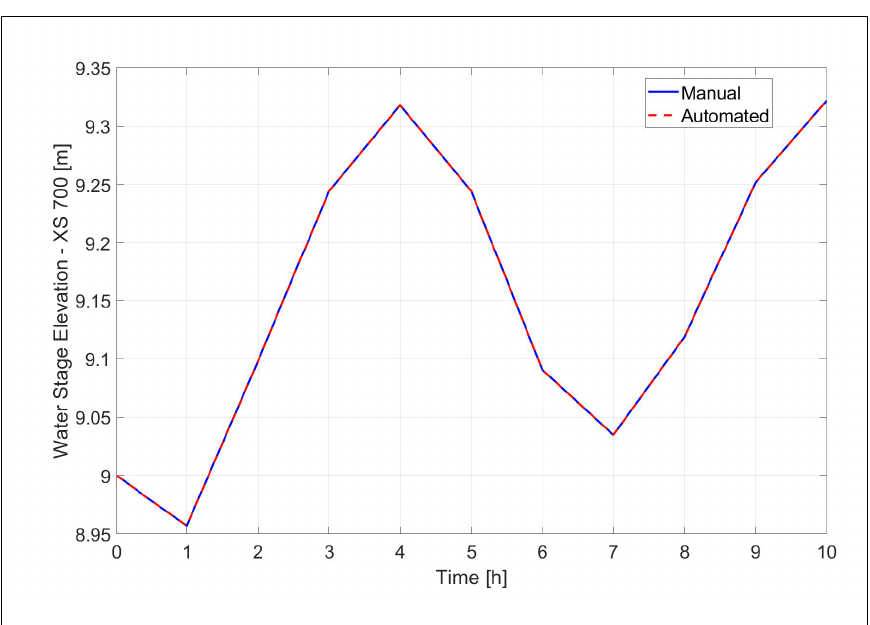
Figure 5. WSE at XS 700 for the rectangular canal— scenario1